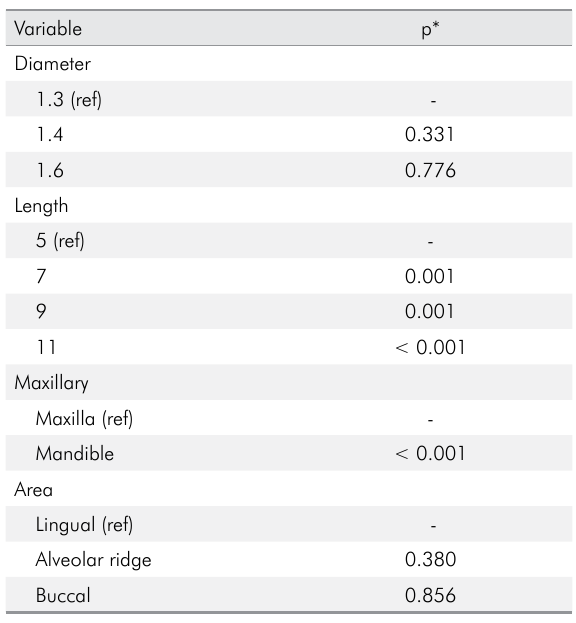
Table 10. Multilevel model analysis considering diameter,